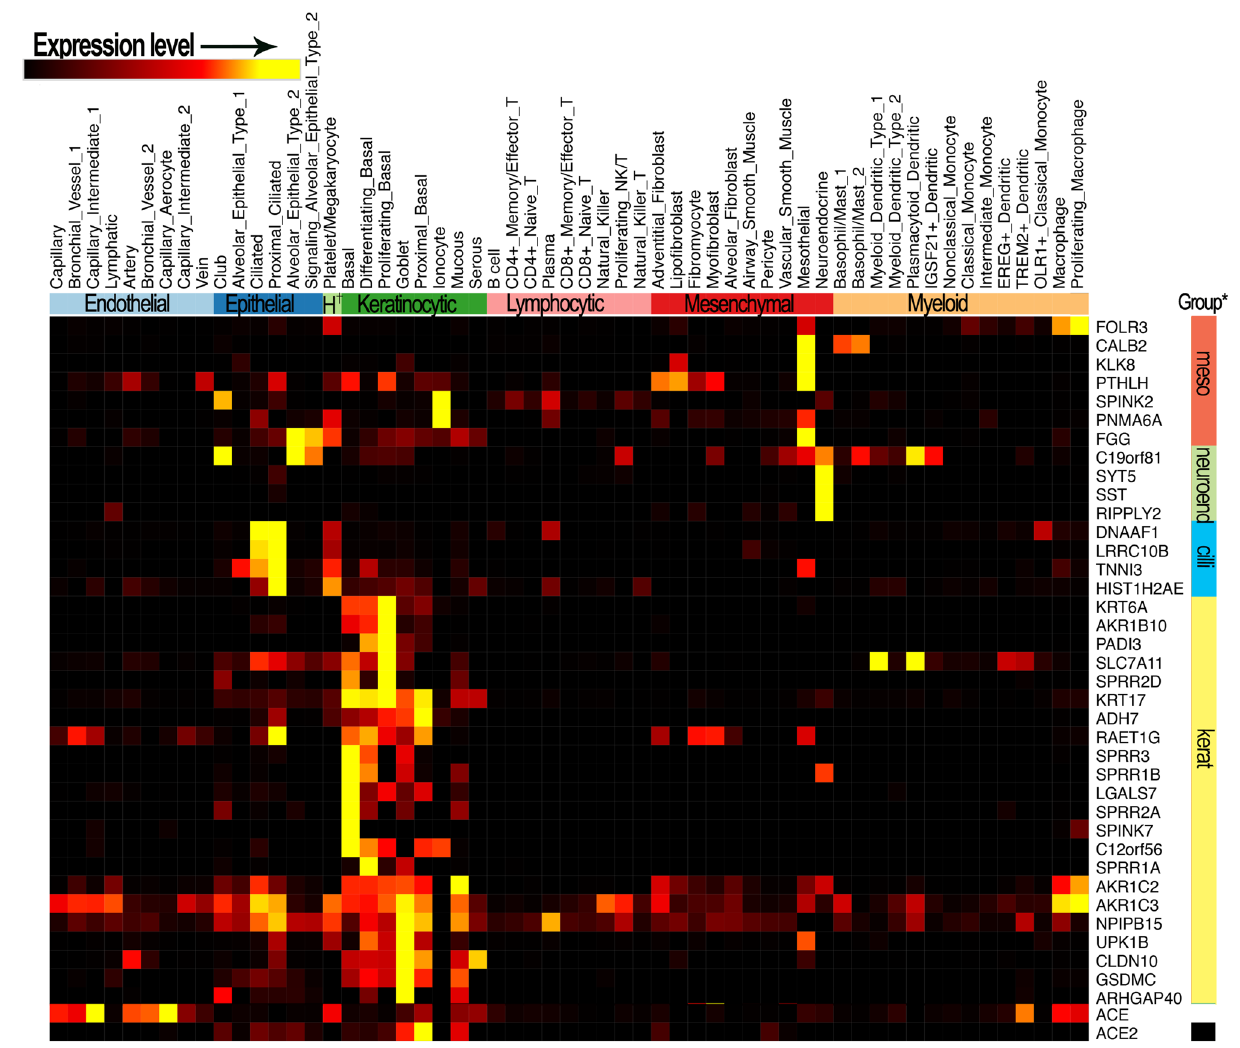
Figure 5. Lung gene signatures upregulated in African Americans versus European Americans map to proximal airway keratinocytic epithelial lineage, and to mesenchymal mesothelial and neuroendocrine cells. Marker genes for kerotinocytes (genes marked by yellow, far right bar); ciliated epithelial cells (genes marked by turquoise, far right bar); mesothelial mesenchymal cells (genes marked by red, far right bar); and neuroendocrine mesenchymal cells (mesenchymal). Note that the keratinocytic proximal basal epithelial cell is the cell subtype with the highest expression of ACE2 receptor, a major target of COVID-19 (ACE2 marked by black on bar at right). ToppCell-constructed gene modules (http:// toppc ell. cchmc. org) for each of the cell types reported to be present in the large scRNA-Seq dataset from lung 36